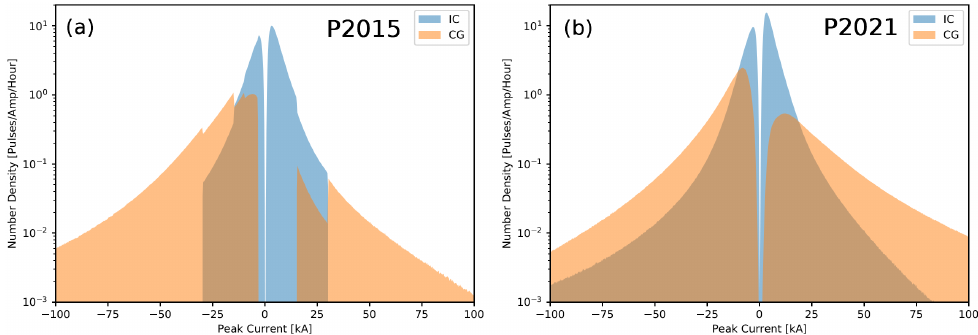
Figure 2. IC/CG peak current distributions for pulses (detected between 3 December 2021 and 14 April 2022) that are classified by the ( a ) old (P2015) and ( b ) new (P2021)